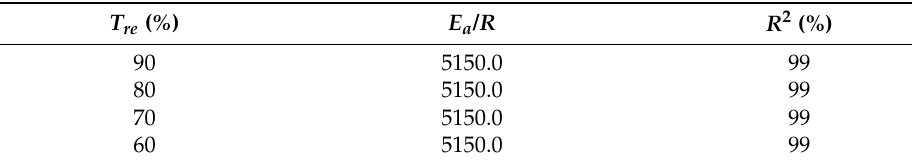
Table 17. Values of E a / R (G2) based on the fourth prediction model. T re ( % )